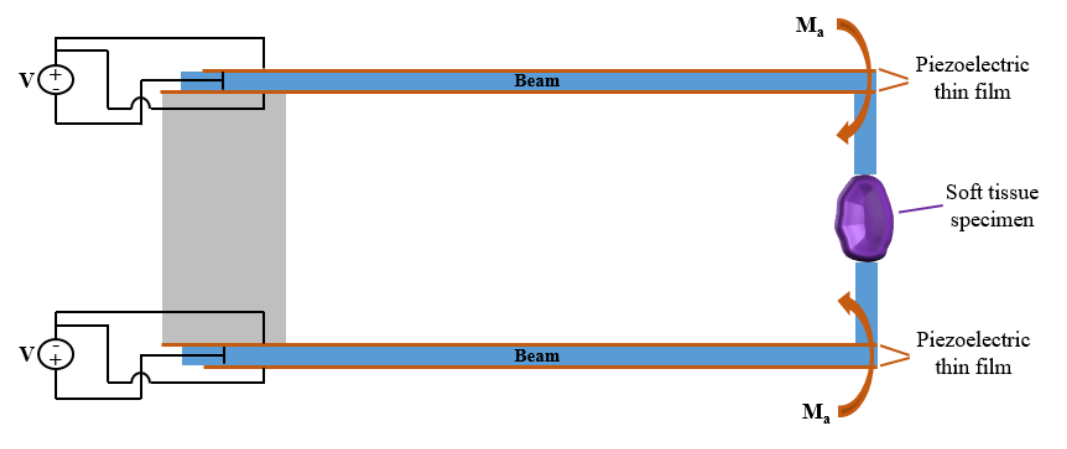
Figure 4. PiezoMEMS grip of the soft tissue.